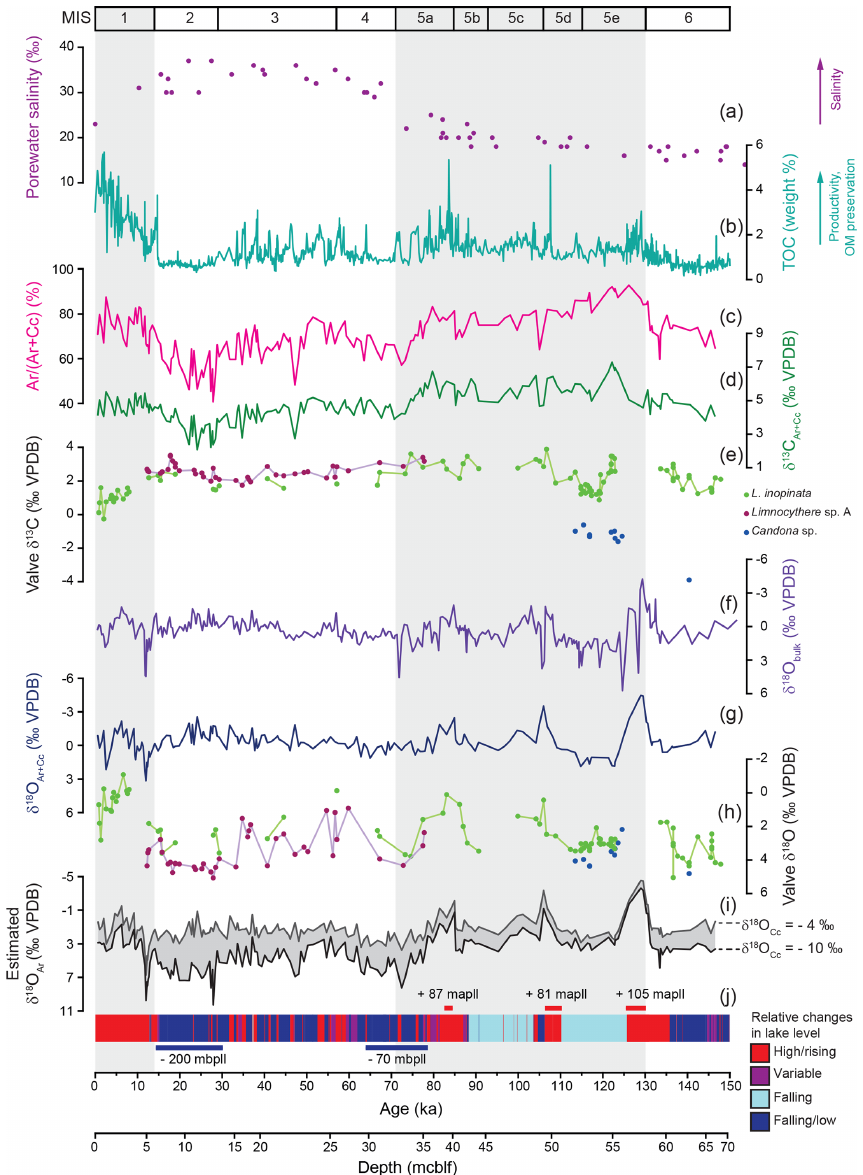
Figure 8. Ostracod isotopy compared with porewater salinity and inorganic carbonate isotopy and mineralogical composition. (a) Porewater salinity plotted against depth in metres’ composite below lake floor (mcblf; Tomonaga et al., 2017). (b) Total organic carbon content (Stock- hecke et al., 2014a). (c, d, g, i) Inorganic mineralogy and isotopy from McCormack at al. (2019). (c) Relative aragonite content of dolomite poor samples ( < 15% dolomite) expressed by an aragonite/non-dolomite ratio Ar / (Ar + Cc) in weight % and (d, g) isotopic composition of dolomite poor samples ( δ 13 C Ar + Cc and δ 18 O Ar + Cc ). (f) Bulk carbonate oxygen isotope composition from Kwiecien et al. (2014). (i) Es- timated δ 18 O Ar values for δ 18 O Cc values between − 4‰ and − 10‰. (j) Lithology-based relative lake level changes (simplified according to Stockhecke et al., 2014a) and major lake level variations (Stockhecke et al., 2014a; Tomonaga et al., 2017) in metres above/below present lake level (mapll/mbpll). (e, h) Valve δ 18 O values and δ 13 C